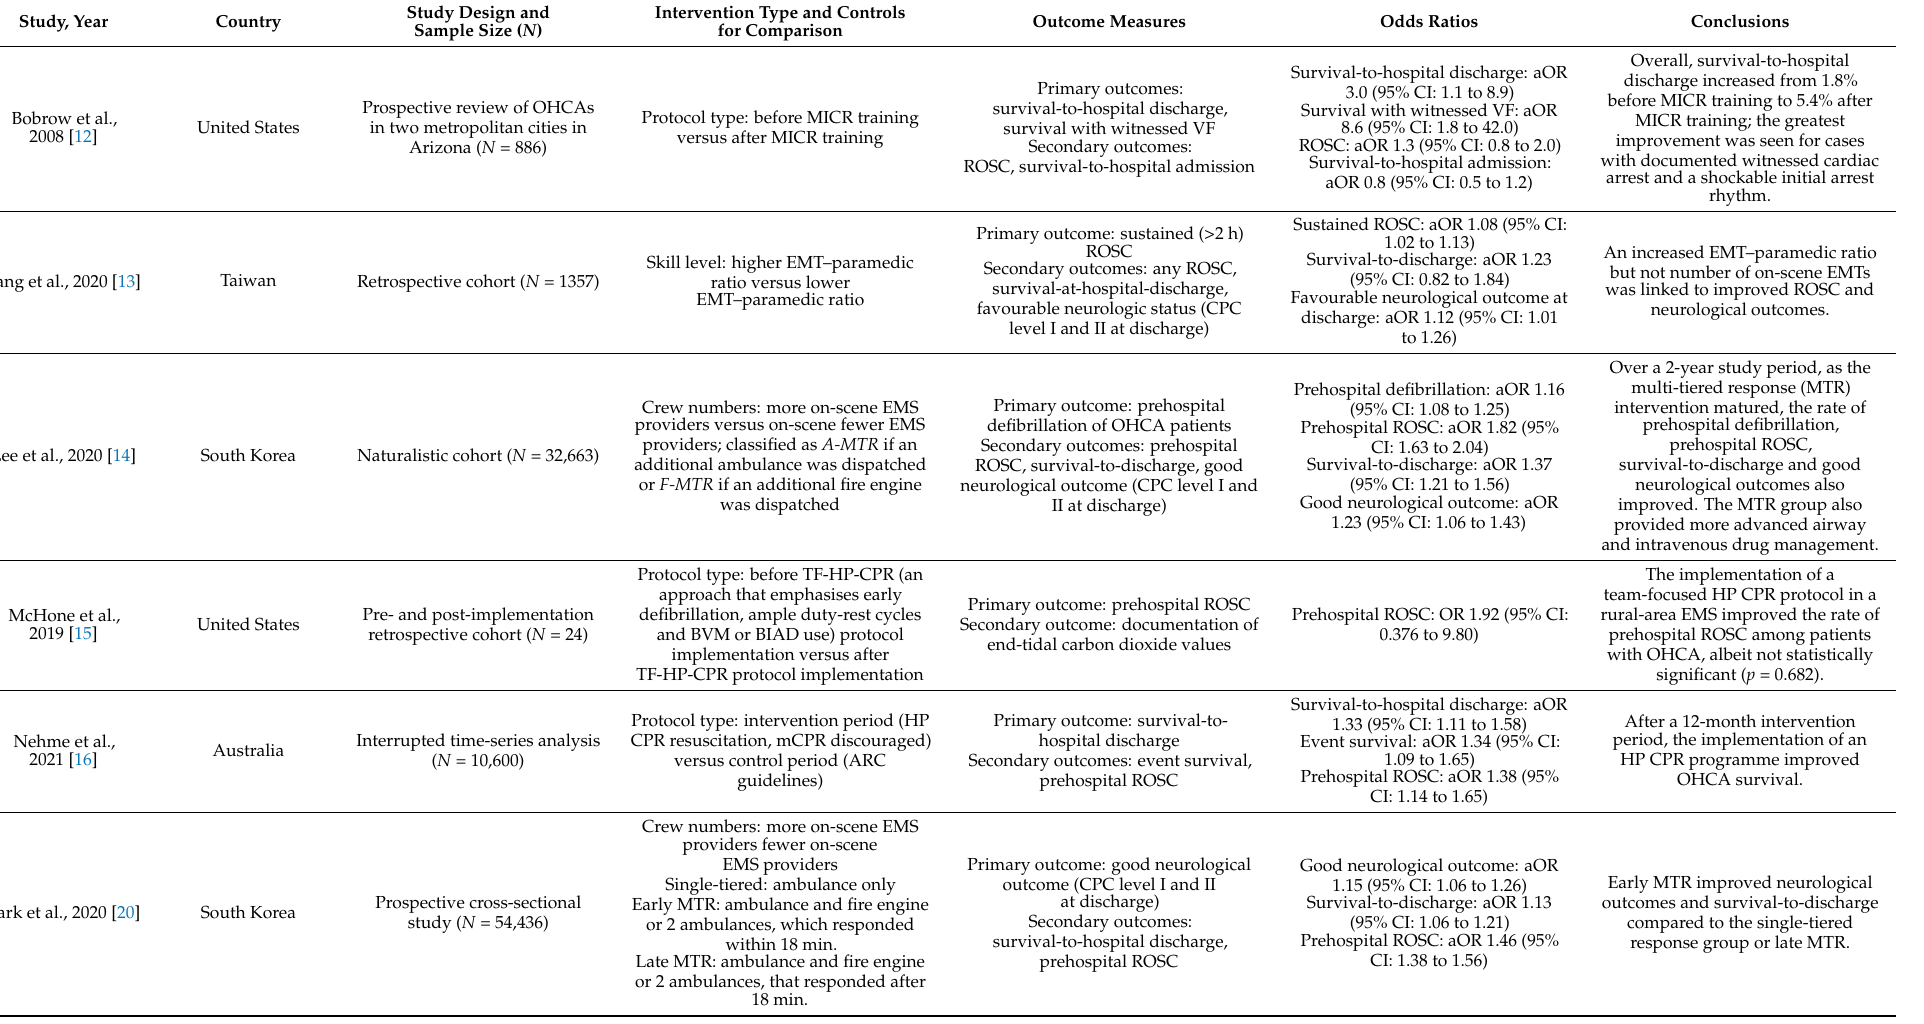
Table 1. Available studies on the implementation of HP CPR or similar interventions and OHCA